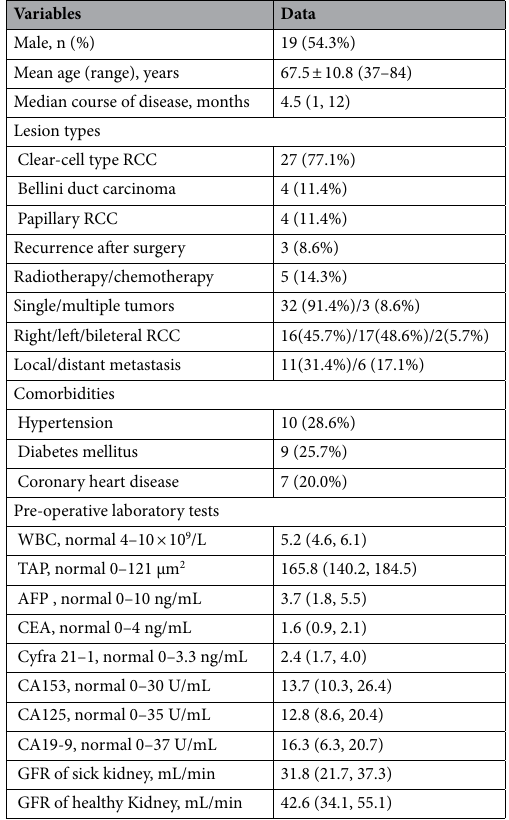
Table 1. Patient characteristics at admission. TAP = Tumor abnormal protein; AFP = Alpha fetoprotein; Cyfra = cytokeratins, non-small cell lung cancer antigen; CA = Carbohydrate antigen.